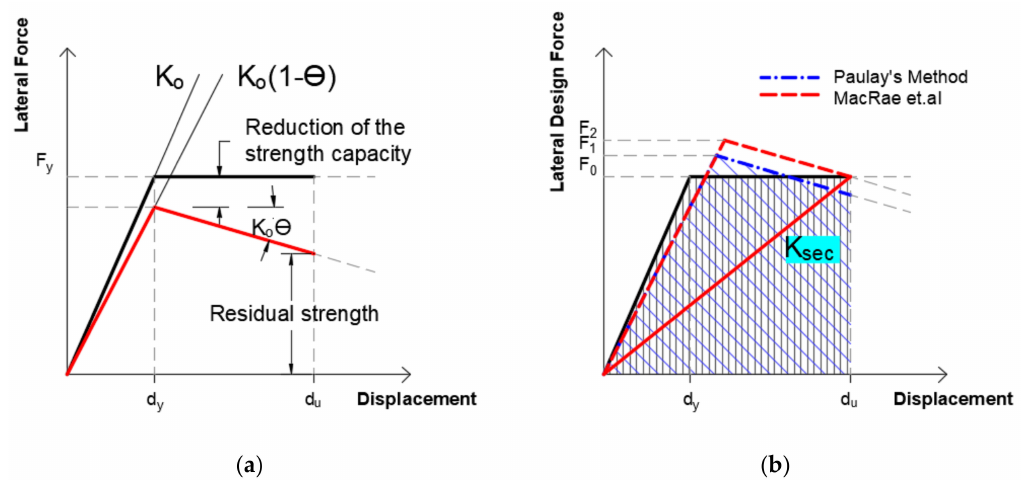
Figure2. ( a )Lateralforce—displacementrelationshipwithandwithout P - ∆ e ff ect; ( b )designapproaches under P - ∆ e ff